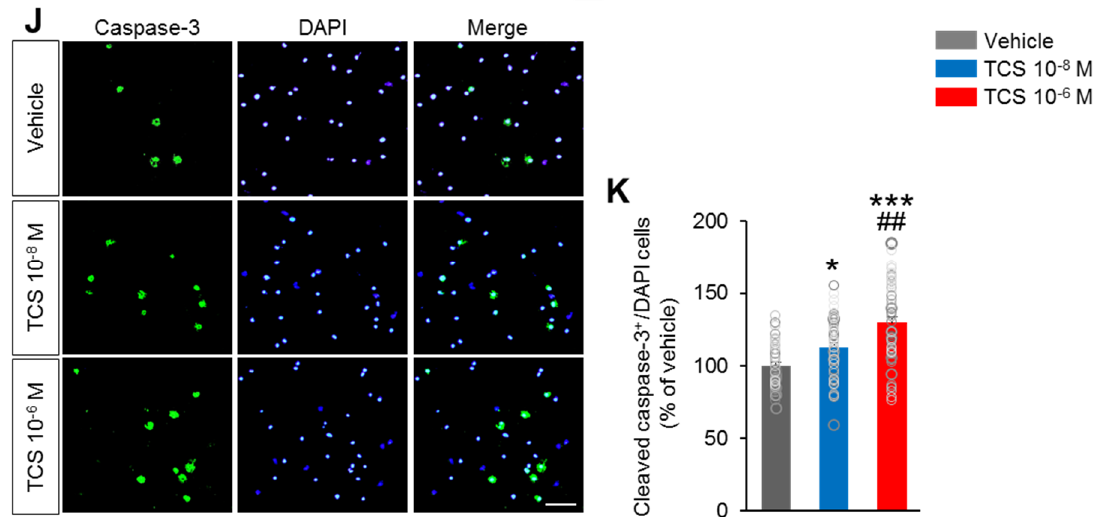
Figure 1. TCS impair to axon and dendrite growth. ( A ) Representative images of cultured mouse cortical neuron fluorescently labeled for MAP2 and Tau1. Scale bar, 100 µm. ( B – D ) Quantification of primary and secondary dendrite. ( B ) Number of primary dendrites, ( C ) number of secondary dendrites, ( D ) Average dendrite length. TCS 10 −8 M group showed a markedly decreased the length of primary dendrites but did not change the number of primary dendrites and secondary dendrites compared to vehicle group. TCS 10 −6 M group exhibited the significantly lower in the number of primary dendrites. The length of primary dendrites was also decreased in the TCS 10 −6 M group compared to the vehicle group. ( E – G ) Quantification of primary and secondary axon. ( E ) Number of primary axons, ( F ) number of secondary axons, ( G ) average axon length. TCS 10 −8 M group showed no significant difference in the number of primary and secondary axons. The length of axon and the number of primary axons were also decreased in TCS 10 −6 M compared to the vehicle group. n = 5 cell culture replicates using 5 mice for each condition (cell counts: 250 cells for each group). ( H ) Primary cortical neuronal cells were cultured from E15 mice and treated TCS at DIV 1. The cells were then incubated with 10 µM BrdU for 2-4 h after 12 h adding TCS, fixed and immunofluorescence with BrdU antibodies. Scale bar, 40 µm. ( I ) Quantification of A. TCS-treated groups exhibited lower in the percentage of cleaved BrdU + cells compared to vehicle group. The percentage of cleaved BrdU + cells in the TCS 10 −6 M group was significantly lower compared to the TCS 10 −8 M group. (J) Cell death was assessed in vehicle and TCS-treated groups by immunofluorescence using a cleaved caspase-3 antibody on DIV 2. Scale bars, 100 µm. ( K ) Quantification of C . The percentage of cleaved caspase-3 + cells was markedly higher in TCS 10 −8 M and TCS 10 −6 M groups. The percentage of cleaved caspase-3 + cells in the TCS 10 −6 M group was higher compared to the TCS 10 −8 M group (cell counts: 1,000 cells for each group). Data represent mean ± SEM. Statistical significance was determined by one-way ANOVA with Bonferroni correction. * p < 0.05 vehicle vs. TCS, ** p < 0.01 vehicle vs. TCS, *** p < 0.001 vehicle vs. TCS, ## p < 0.01 TCS 10 −8 M vs. TCS 10 −6 M, ### p < 0.001 TCS 10 −8 M vs. TCS 10 −6 M. Treatments: vehicle; 0.1% DMSO, TCS; 10 −6 mol/l or 10 −8 mol/L.